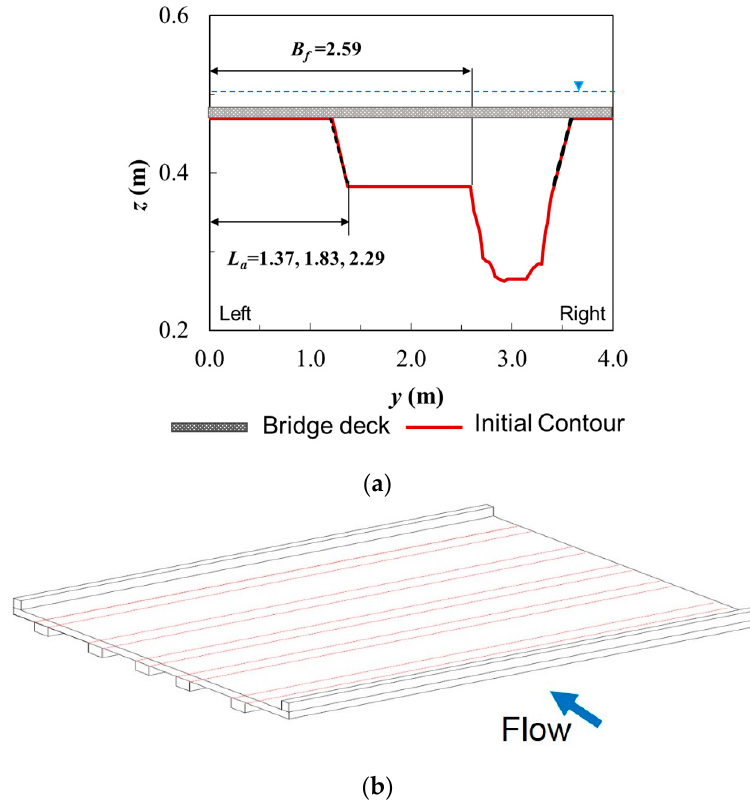
Figure 2. Geometries for ( a ) compound channel and abutment before scouring and ( b ) shape of model bridge deck.